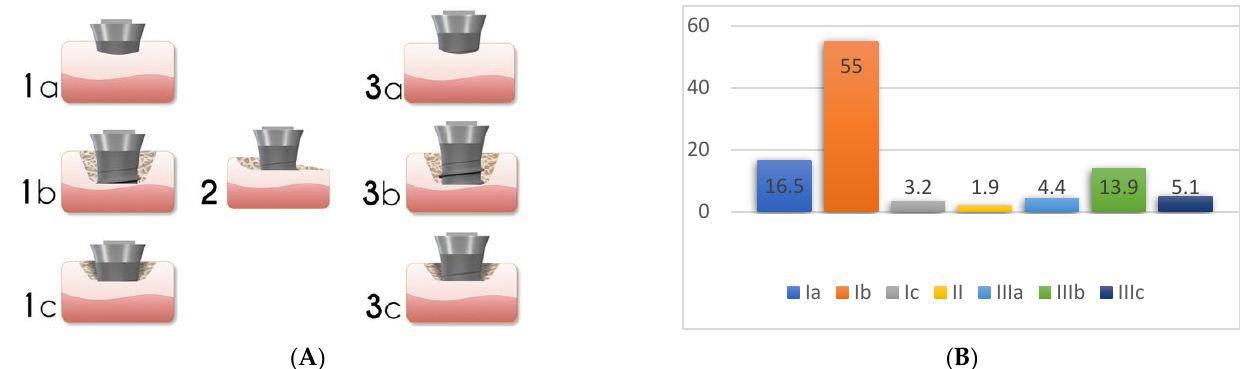
Figure 5. Peri-implant bone defect classification according to Monje et al. [23] (Adapted from original paper) ( A ). The figure is a representation of: Class I Infra-osseous defects, Class II Supra-crestal/Horizontal defects, and Class III Combined defects. Sub-classifications a (buccal dehiscence), b (2 – 3 wall defects), and c (circumferential configurations). ( B ) Prevalence of the different defect morphology types according to Monje et al. [23].